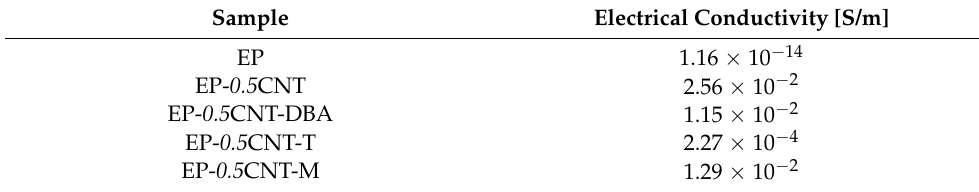
Table 4. Values of the electrical conductivity for the analyzed